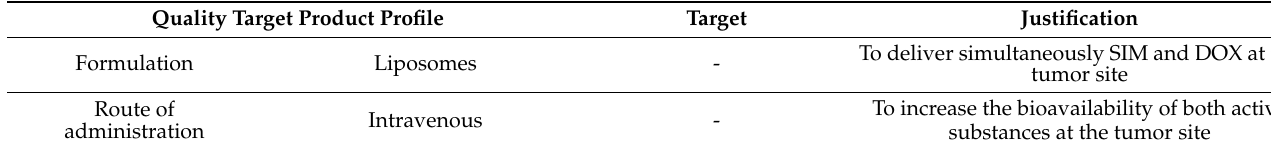
Table 2. The summary of QTPP and CQAs of